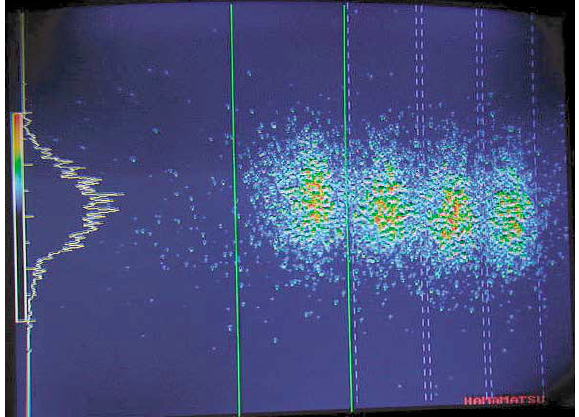
FIG. 12. (Color) A typical streak camera image of a single train of bunches in CESR with the longitudinal feedback turned off and the LDCBI